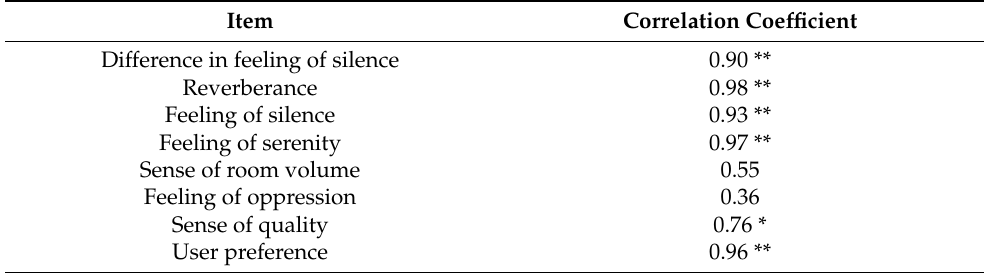
Figure 7. Results of the psychological experiment using recording sources and headphone listening. The eight figures show the psychological values of the five absorption patterns (A–E) for each subjective item. The error bars represent the 5% significant yardsticks. Table 5. Correlation coefficients between the psychological values of the full-scale modeling experiment and those of the headphone listening experiment for each evaluation item.